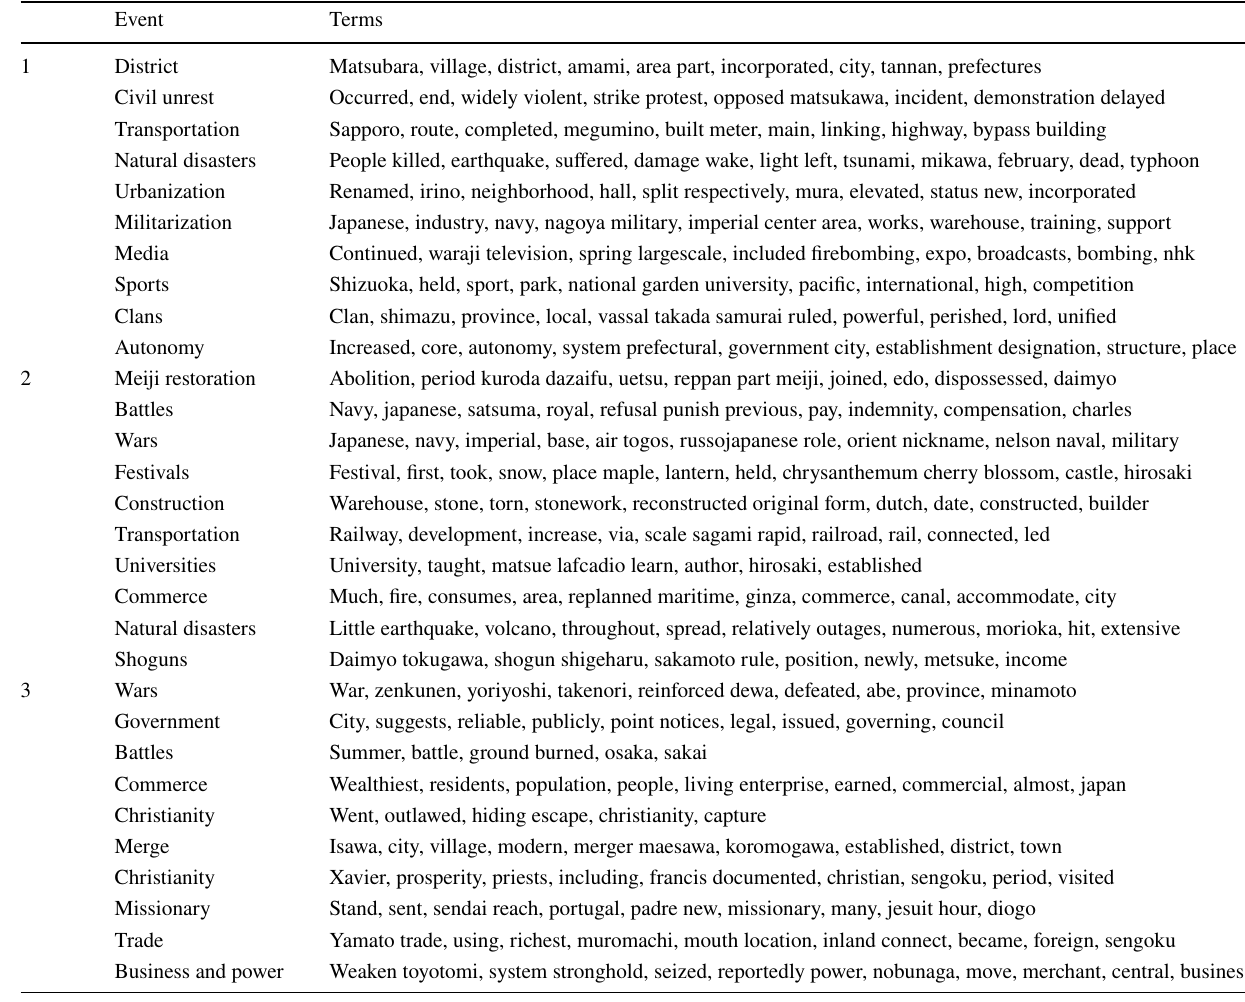
Table 6 Events in the summary of Japanese cities (see Fig.